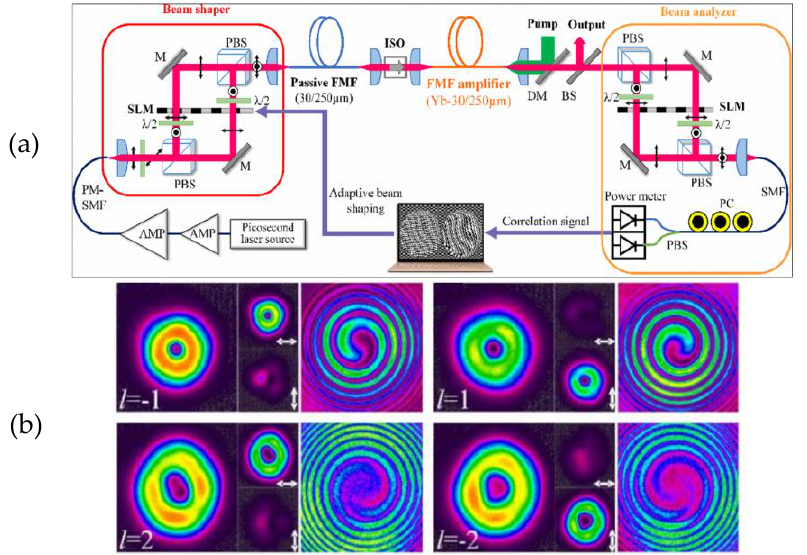
Figure 15. ( a ) Schematic of the fibre laser. ( b ) Intensity distributions and corresponding phase patterns of vortex beams carrying different OAM values (Adapted from an open-access source Ref. [102]).